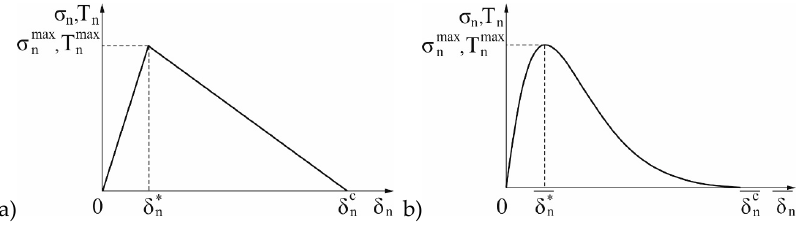
Figure 2. Bilinear ( a ); and exponential ( b ) law of delamination.